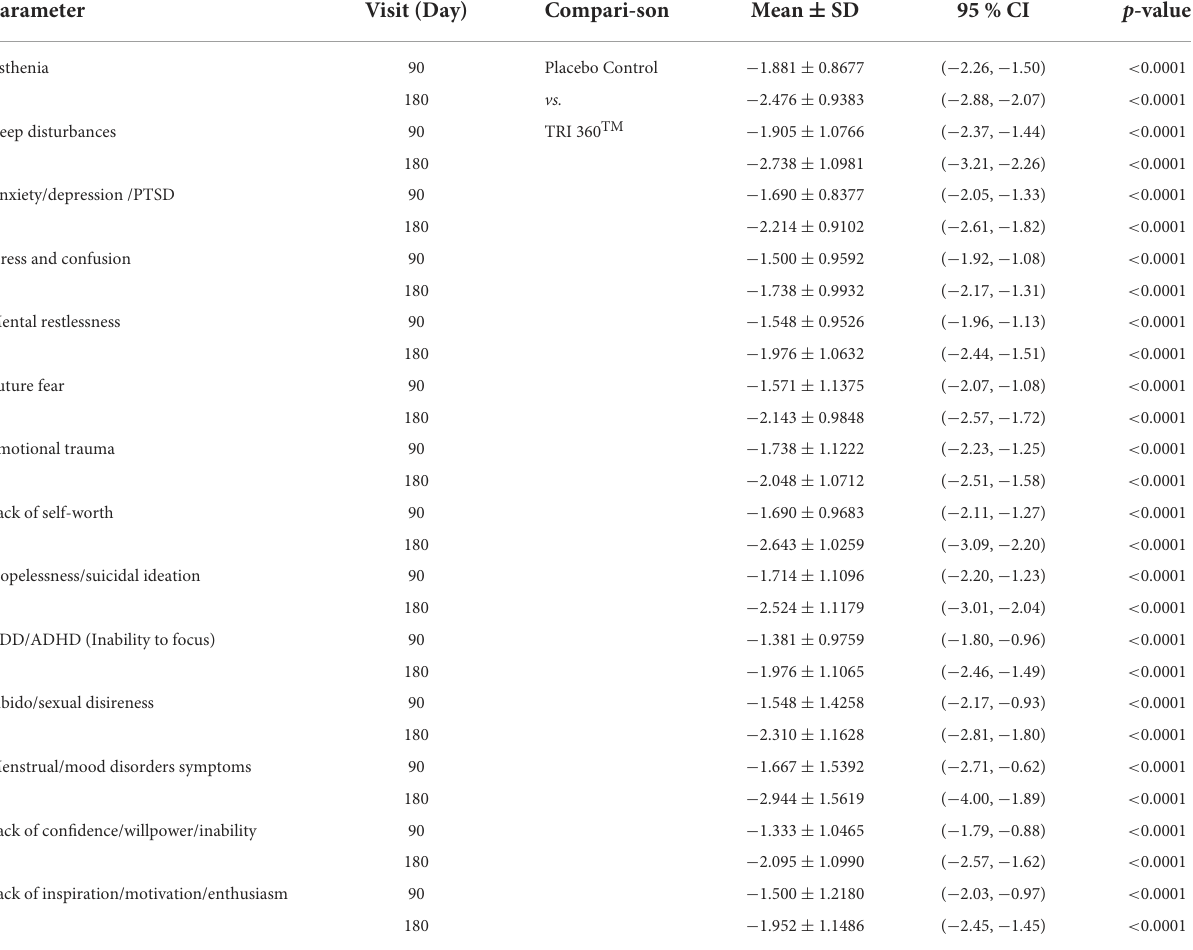
Lack of inspiration/motivation/enthusiasm